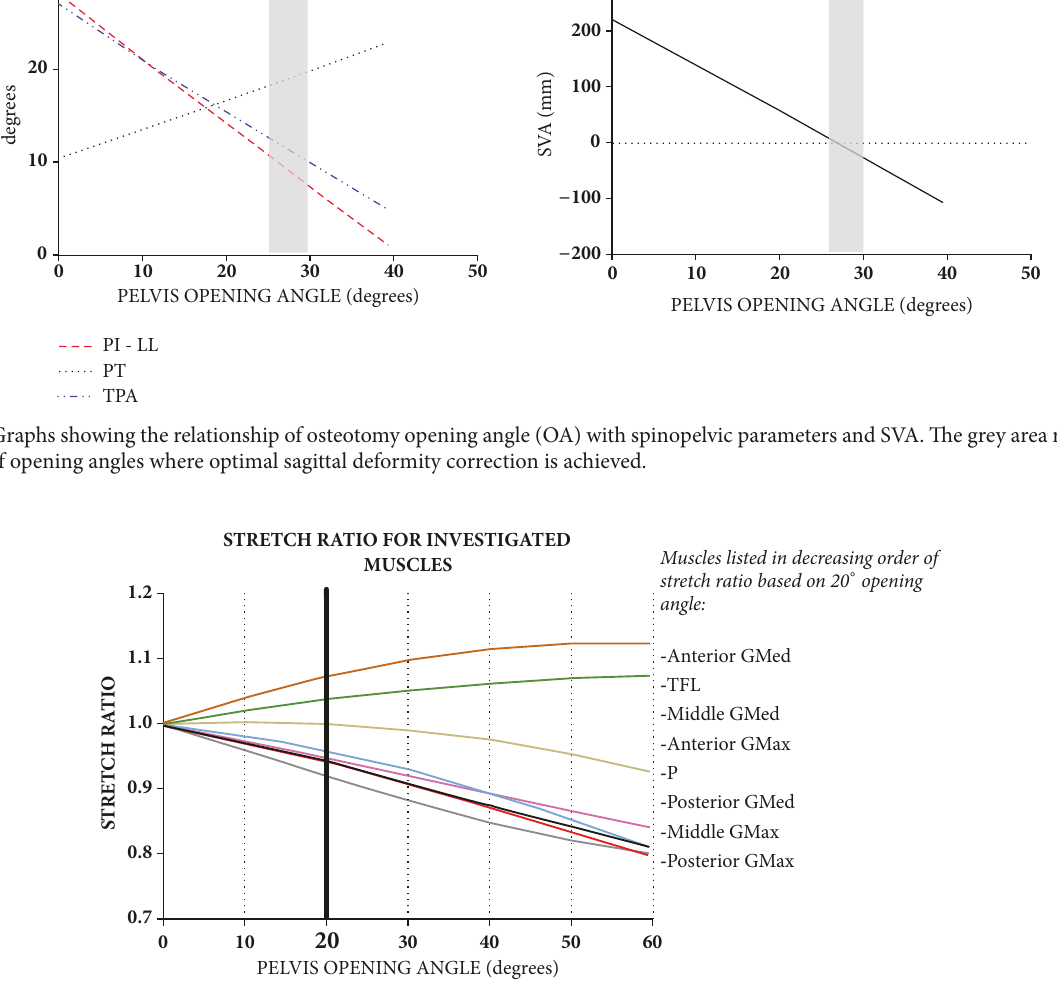
TPA, and SVA and positively with PT. From baseline SVA of 22 cm, a 21 ∘ OA reduced SVA to 5 cm. A 23 ∘ OA reduced TPA to 14 ∘ . A 30 ∘ OA increased PT to 20 ∘ . A 26 ∘ OA decreased